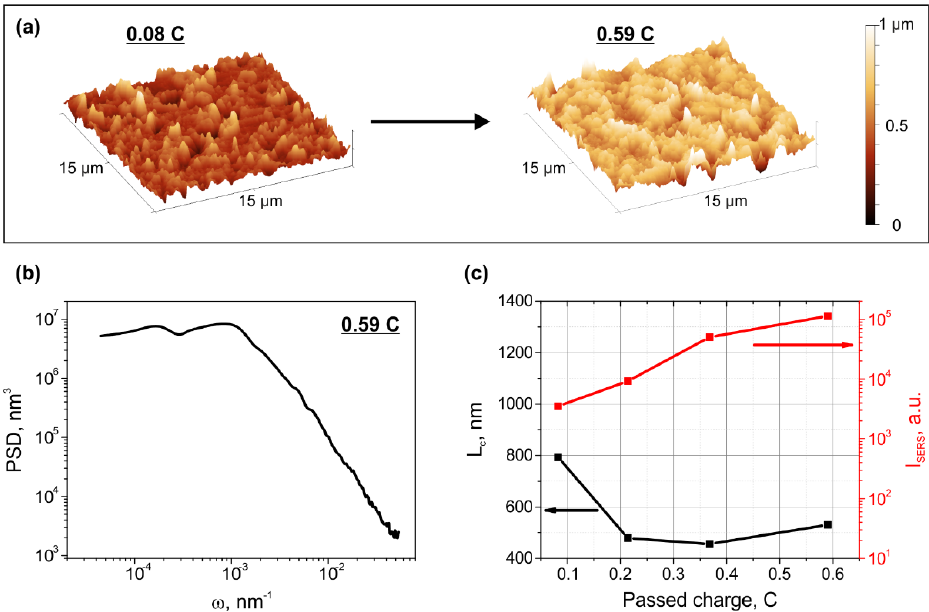
Figure 6. ( a ) Typical AFM images of the dendrites formed on the glass surface via electrolysis for passed charge 0.08 C (left) and passed charge 0.59 C (right). ( b ) PSD function of dendrites formed after passing 0.59 C. ( c ) The dependencies of integral intensity of 1200 cm − 1 BPE Raman peak enhanced by dendrites (right axis, red curve) and dendrites’ correlation length (left axis, black curve) on the passed charge.